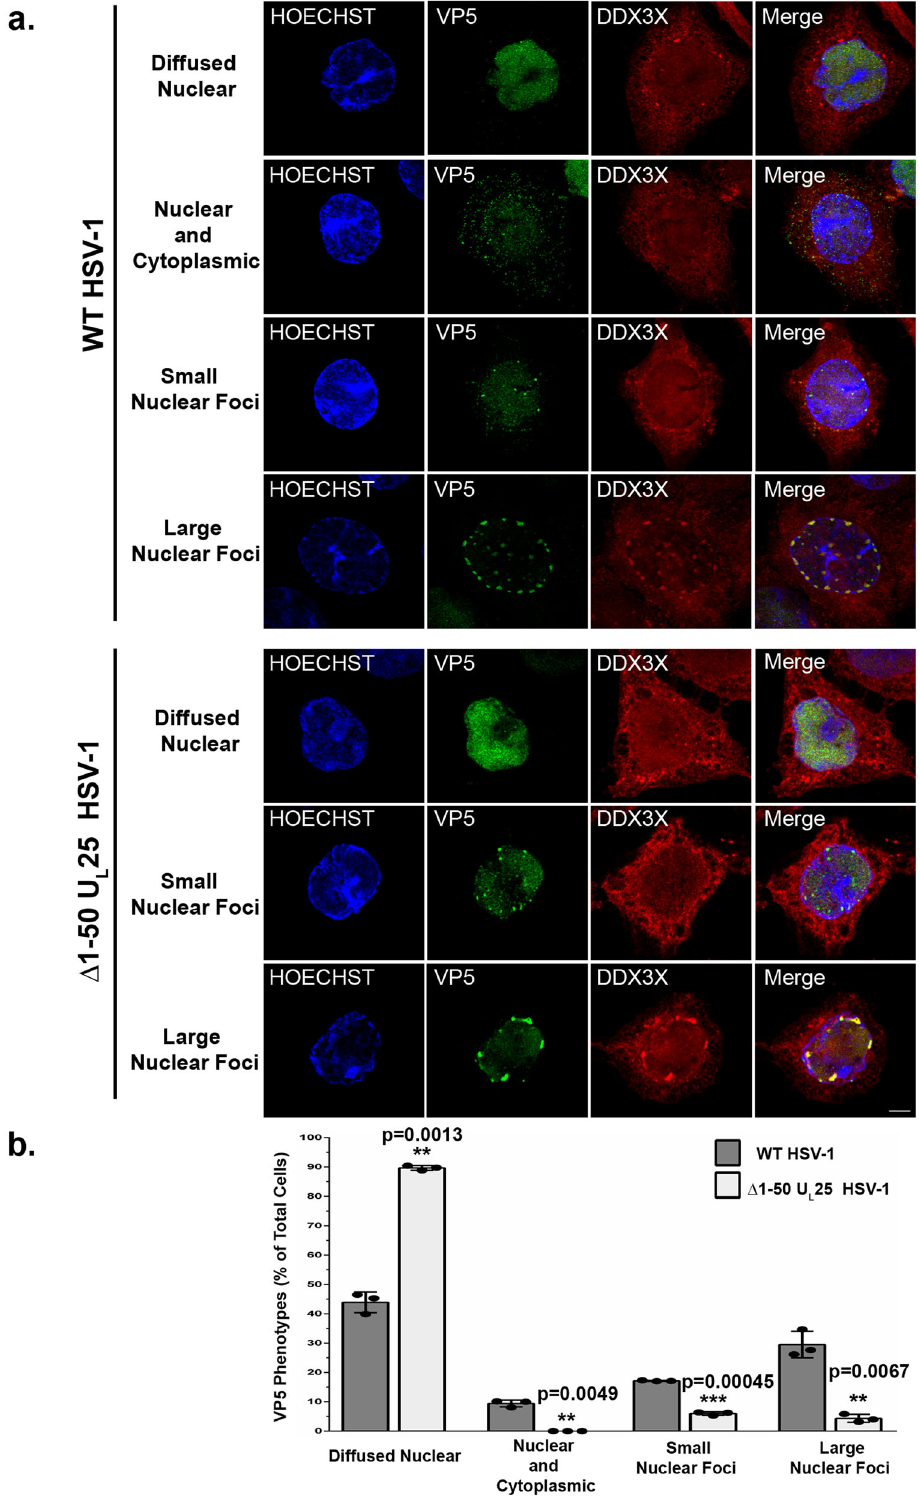
Fig. 6 DDX3X and the large VP5 nuclear aggregates are C-capsids dependent. a HeLa cells were mock-treated or infected at an MOI of 5 with the viral mutant Δ 1-50 U L 25 (only makes A and B nuclear capsids) or corresponding KOS wild-type virus. At 9 hpi, cells were fi xed and processed for immuno fl uorescence (DDX3X: red; VP5: green; Hoechst 33342 stained nuclei: blue). Images were acquired on a conventional confocal microscope. The scale bar represents 5 µ m. b Ten random images (~200 cells per condition) were used to quantify the different VP5 phenotypes. The percentages are means of three independent experiments along with their standard deviation (bilateral Student T -tests; *** p <